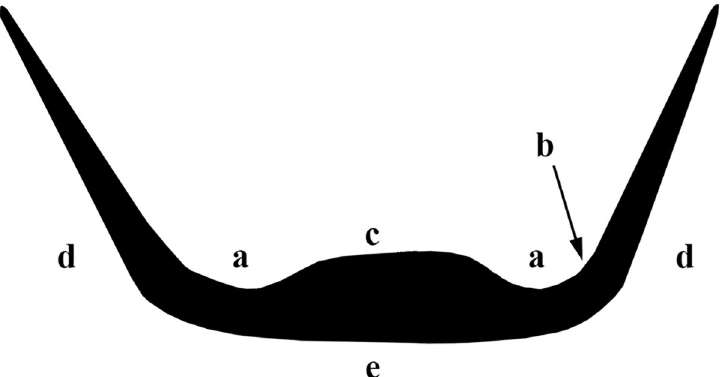
Fig 2. Schematic cross-section of a vessel with a circumferential depression. (a) Circumferential depression; (b) Exterior margin of the circumferential depression; (c) Central elevated base; (d) Exterior wall; (e) Exterior base.